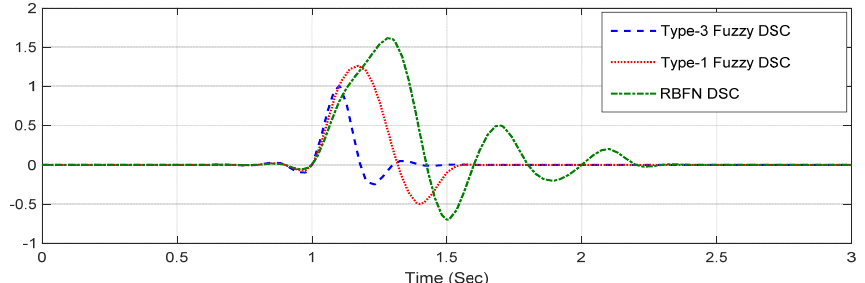
Figure 7. The control signals of the three controllers in Figure 6.